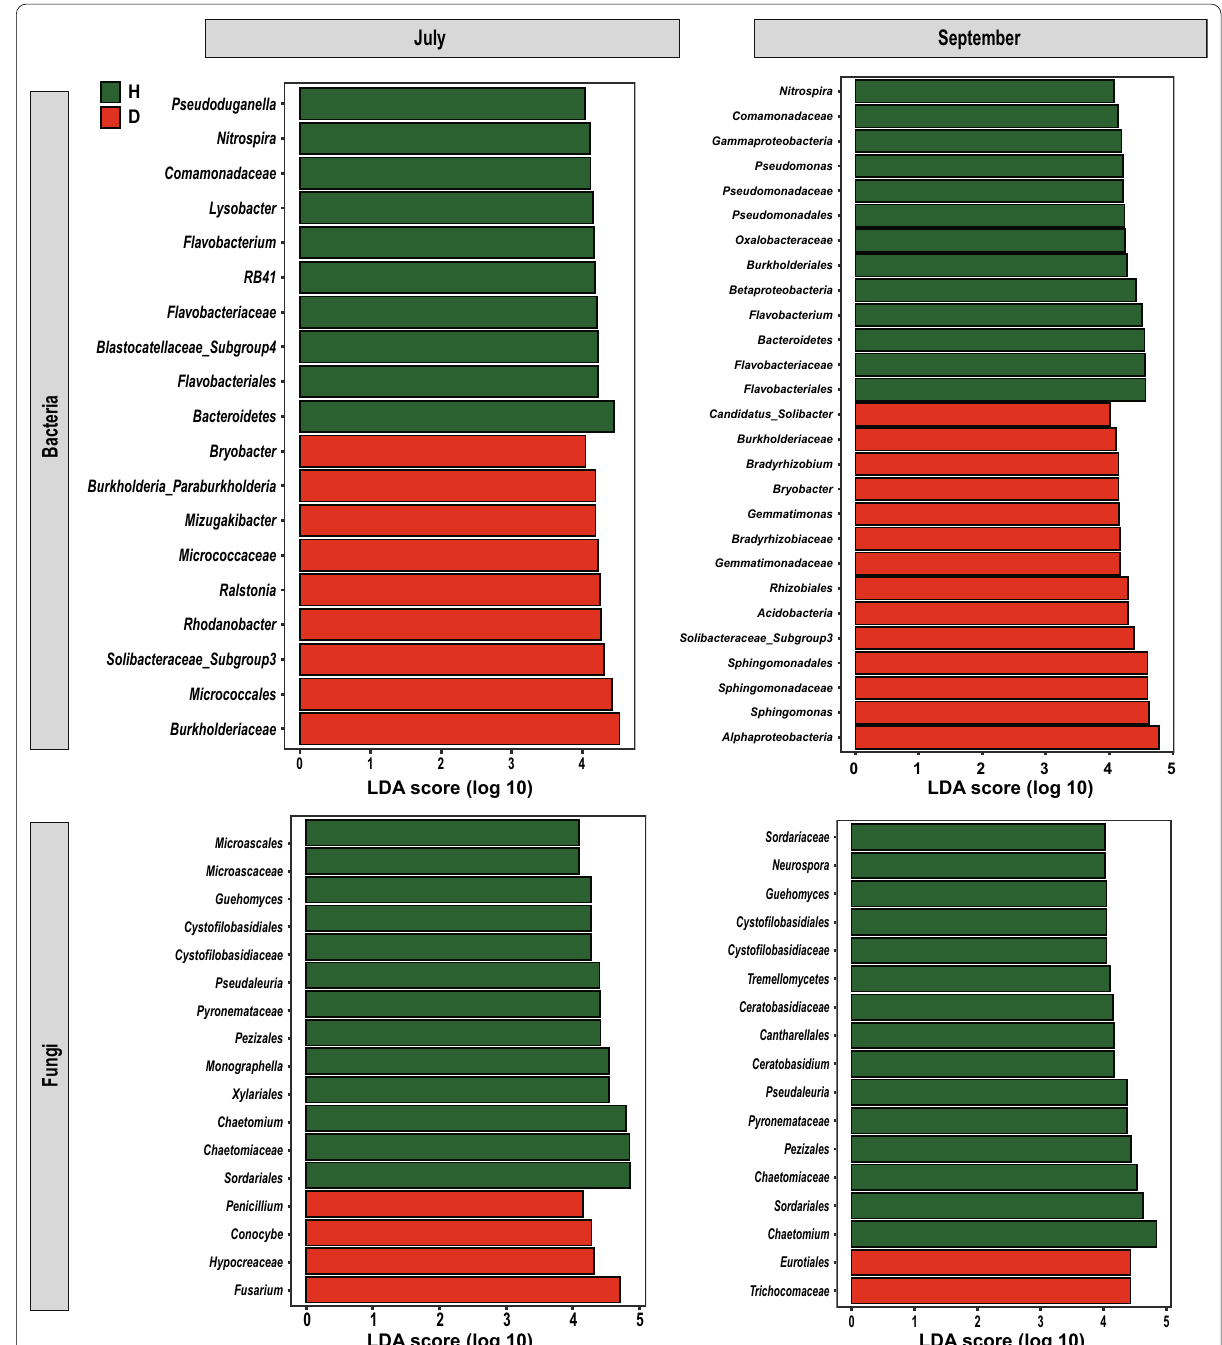
Fig. 3 Histogram of discriminative bacterial and fungal taxa in healthy (H) and diseased (D) rhizosphere samples. Rhizosphere samples indicated the soil samples collected in July and